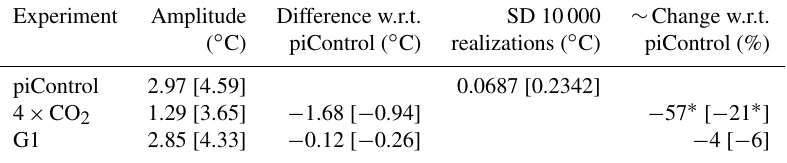
Table 3. Maximum amplitude of warm events.